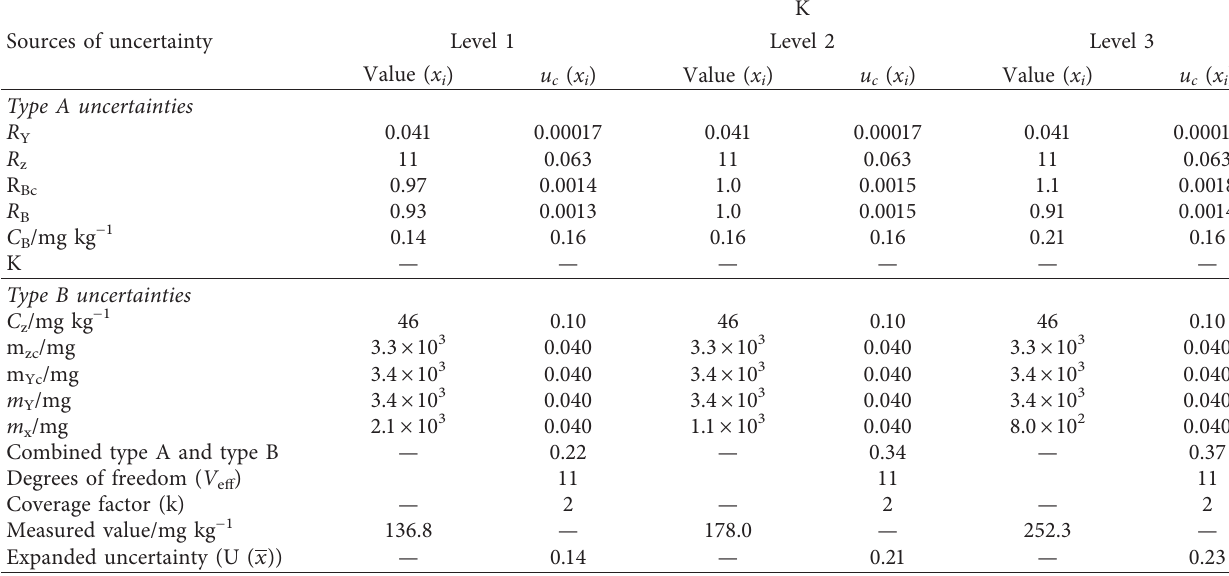
Table 5: Sources of uncertainty in the determination of K.